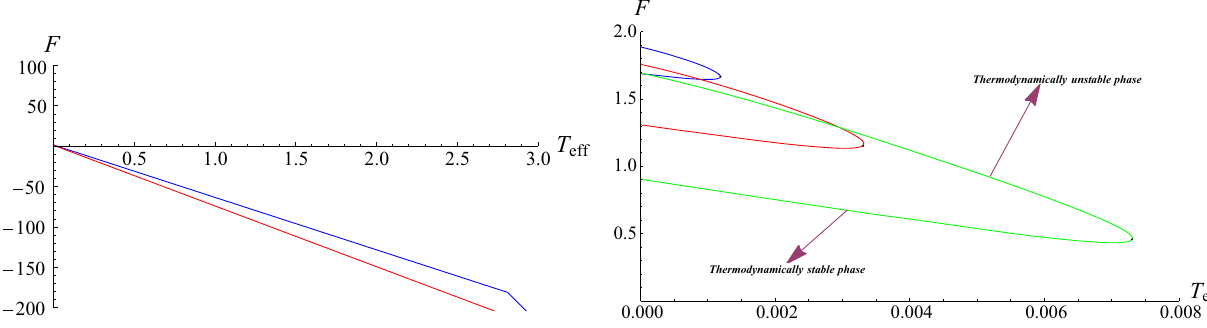
Fig. 12 We plot the free energy F as a function of the effective tem- perature T ef f under the different values of the magnetic charge Q , at r c = 5. The blue, red, and green curves correspond to Q = 2, 1 . 5, 1.